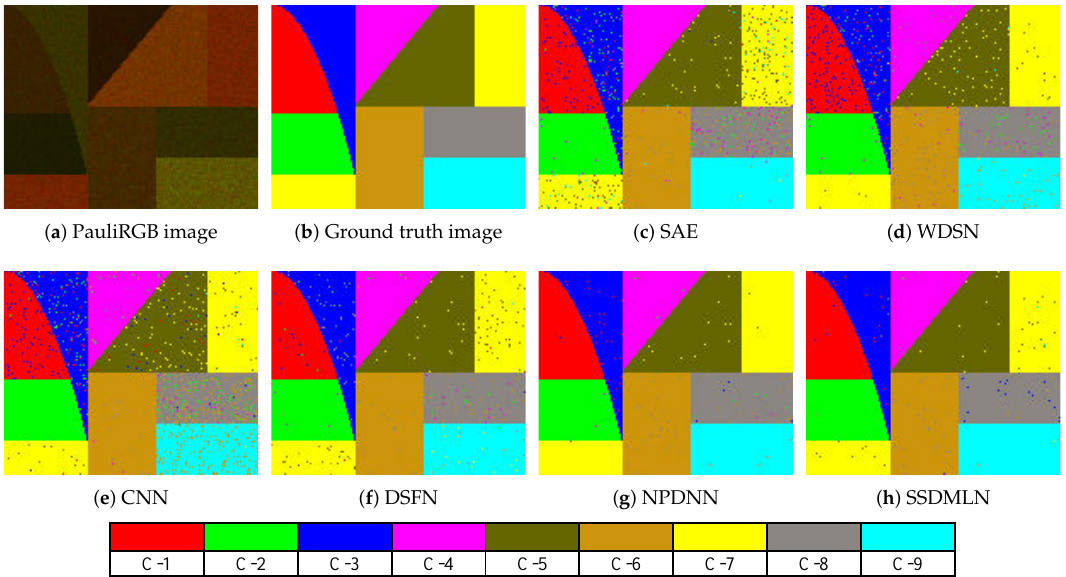
Figure 4. Comparison of classification results on the synthetic data set using 1% labeled data.